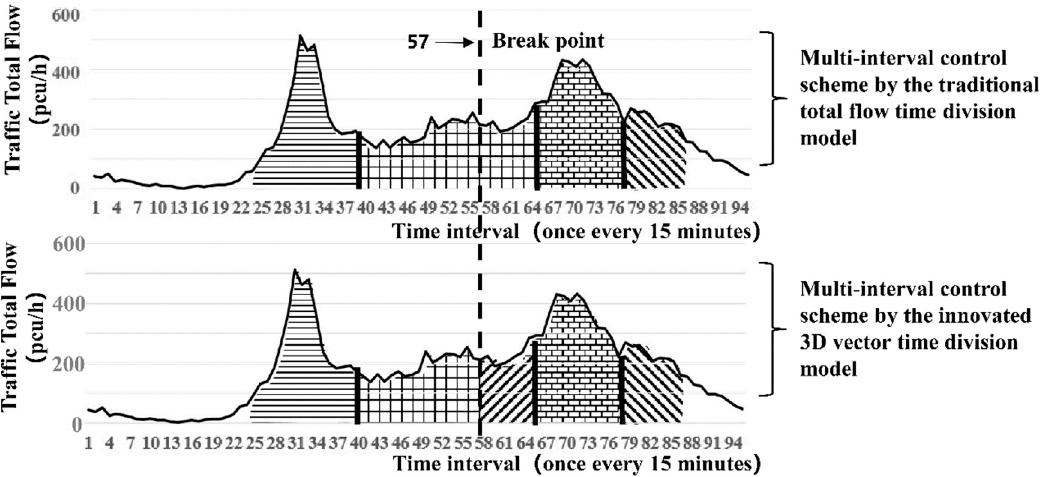
Figure 9. Scheme comparison diagram of the 3D vector time period division with the traditional total flow division (hump-type representative: No. 6 intersection of Jiefang South Road and South Ring Road).